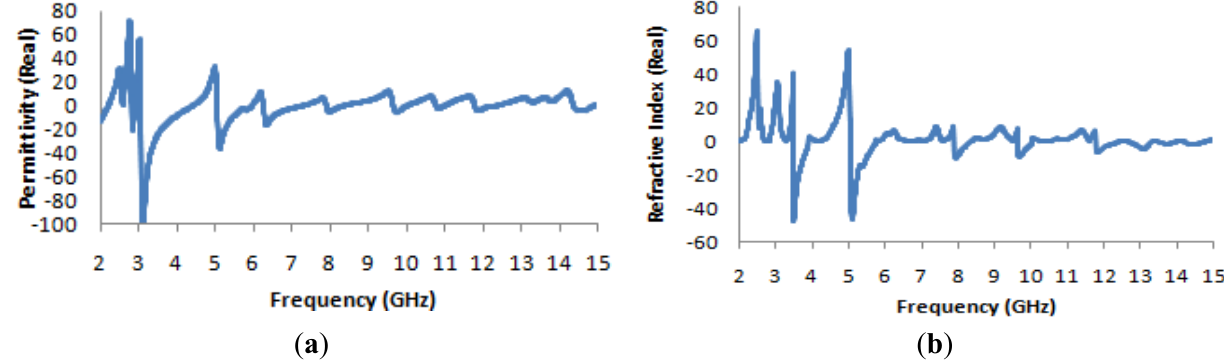
Figure 17. ( a ) The real value of permittivity vs. the frequency for the 2 × 2 unit cell; ( b ) the real value of the refractive index vs. frequency for the 2 × 2 unit cell.